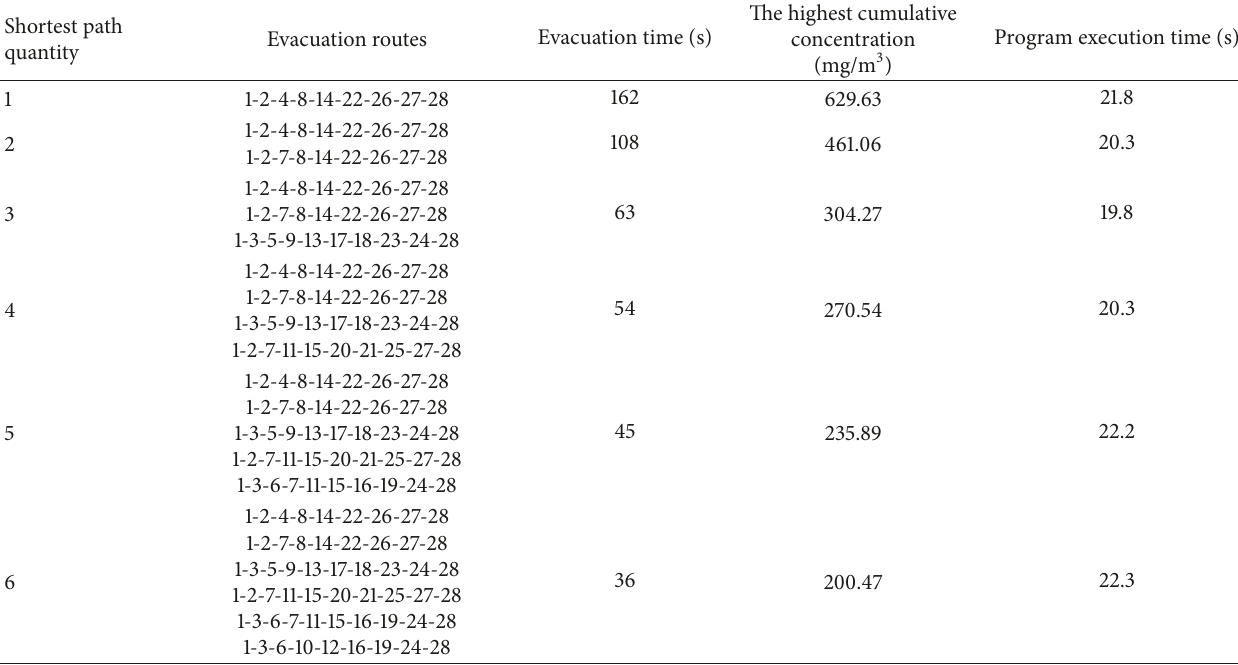
Table 4: The calculative results of different shortest path